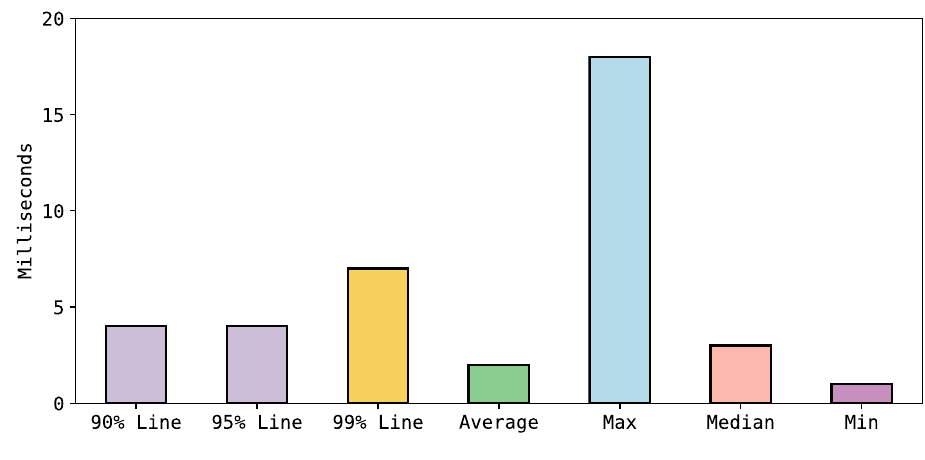
Figure 14. The results of Query 8 for retrieving all nodes to test the DNNPAO load